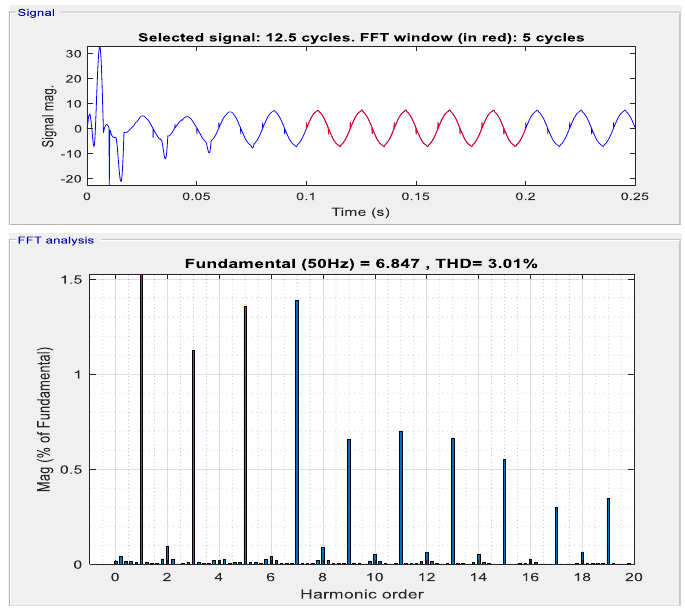
Figure 30. %THD of Source Current (Simulated ANN-based Filter).